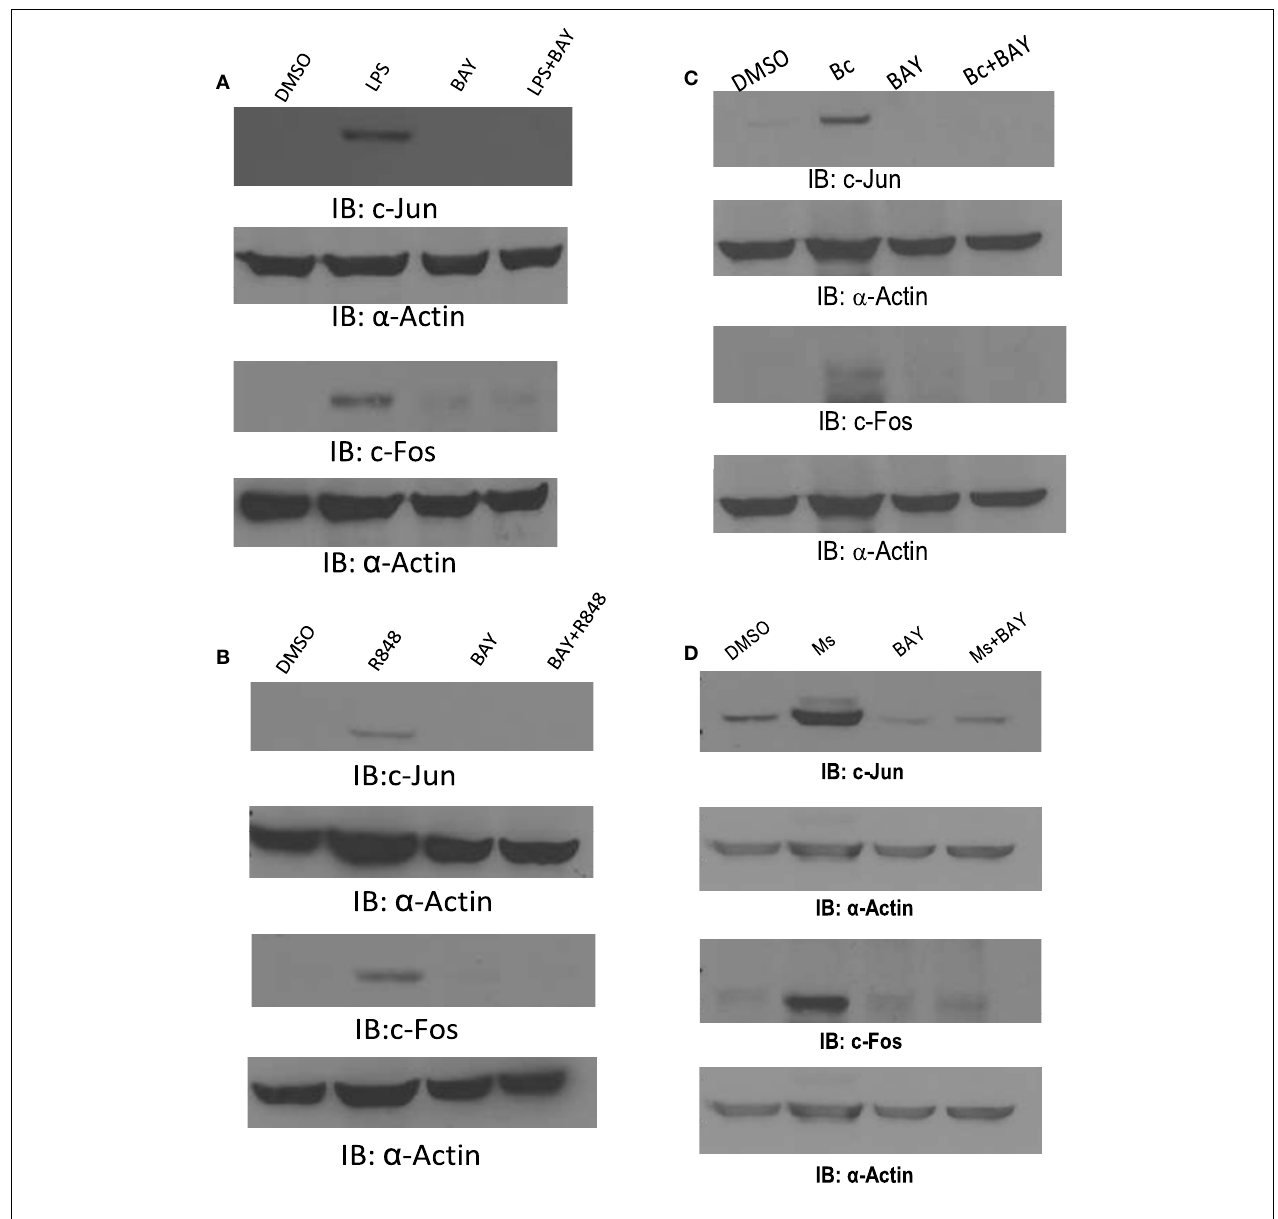
smegmatis ( Ms ) at MOI 5. Cell lysates were collected 16h later. Protein-matched lysates were analyzed byWestern blotting with c-Jun or c-Fos antibodies. All membranes were re-probed with Actin antibody to ensure equal loading of protein in all lanes.These data are representative of four independent